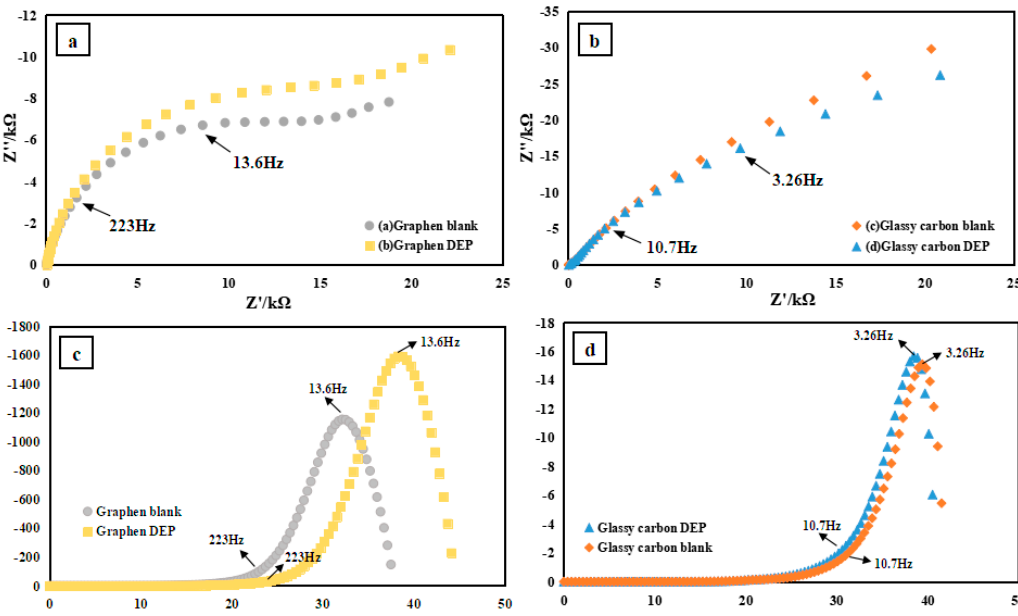
Figure 2. ( a , b ) EIS response comparisons of glassy carbon electrode and graphene electrode. The blank solution contained 0.5 M NaCl and 0.01 M K 3 [Fe(CN) 6 ]. The DEP solution was prepared by adding 100 µ M diethyl phthalate to the blank solution. EIS was carried under an open circuit voltage with an AC amplitude of 10 mV and a frequency range of 1 Hz–0.1 MHz. ( c , d ) Show ( a , b ) after deconvolution treatment, respectively.